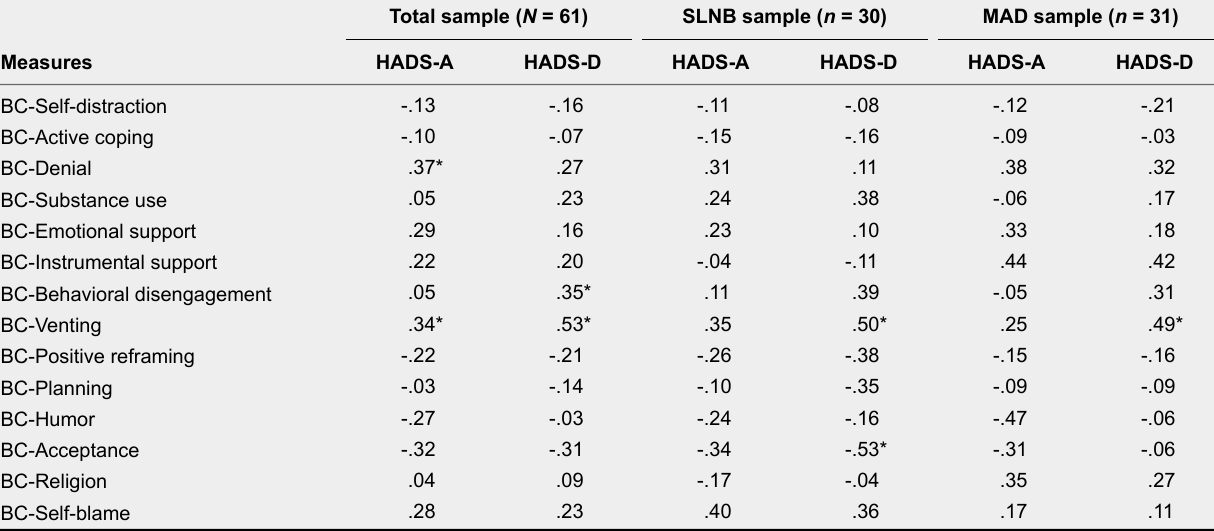
Zero-Order Correlations Between Brief Cope and HADS